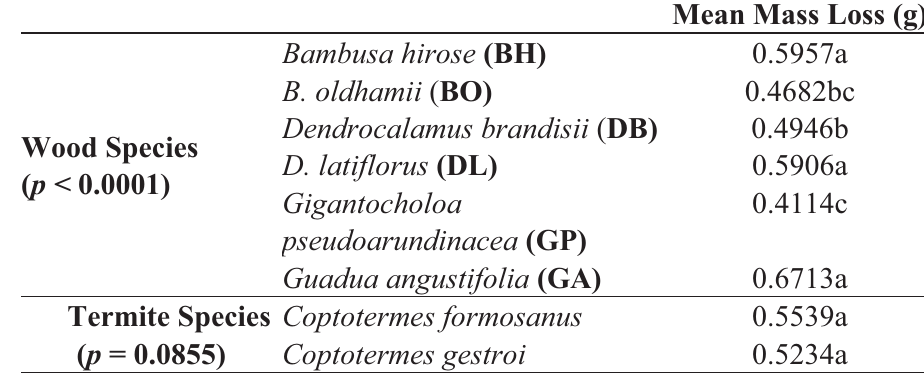
Table 3. Summary of results (Two-way ANOVA, Ryan-Einot-Gabriel-Welsch Multiple Range Test (REGWQ), SAS